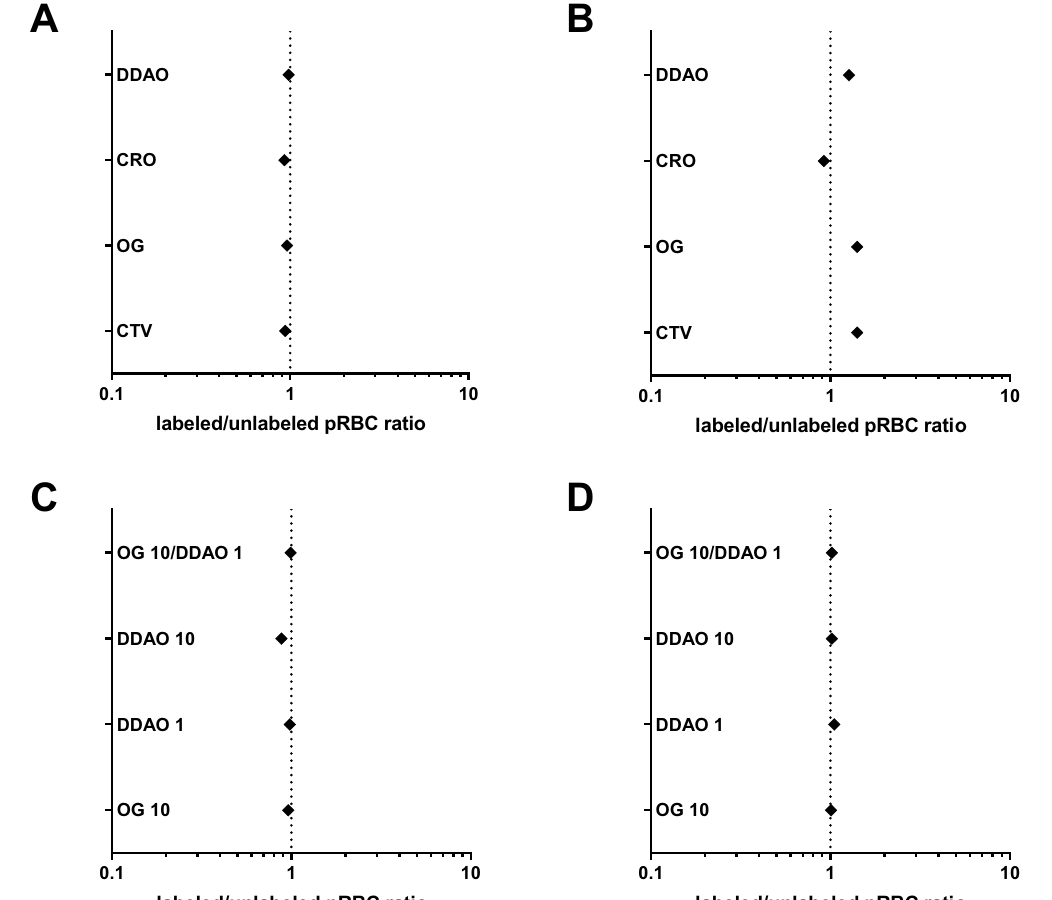
Figure 2. Selection of an optimal cell labelling combination for multiplex invasion of erythrocytes by P. falciparum . The impact of labelling erythrocytes with fluorescent dyes on infection by P. falciparum strain Dd2 was determined by flow cytometry. ( A , B ) Erythrocytes labelled with either CellTrace ™ Far Red (DDAO), Calcein Red-Orange AM (CRO), Oregon Green 488 (OG) or Violet (CTV) were incubated individually ( A ) or altogether ( B ). ( C , D ) Erythrocytes labelled with 1 or 10 µ M of DDAO or 10 µ M of OG or a combination of both were incubated individually ( C ) or altogether ( D ). All cells were incubated in the presence of P. falciparum parasites for 48 h to allow rupture of schizonts and subsequent invasion of labelled and unlabelled erythrocytes. The cells were then stained with Hoechst 33342 and analyzed by flow cytometry to determine the parasitemia of each population and calculate the labelled invaded erythrocyte/unlabelled invaded erythrocyte ratio. Values greater than 1.0 indicate an increased susceptibility to invasion than unlabelled erythrocyte, while values smaller than 1.0 indicate an increased resistance to